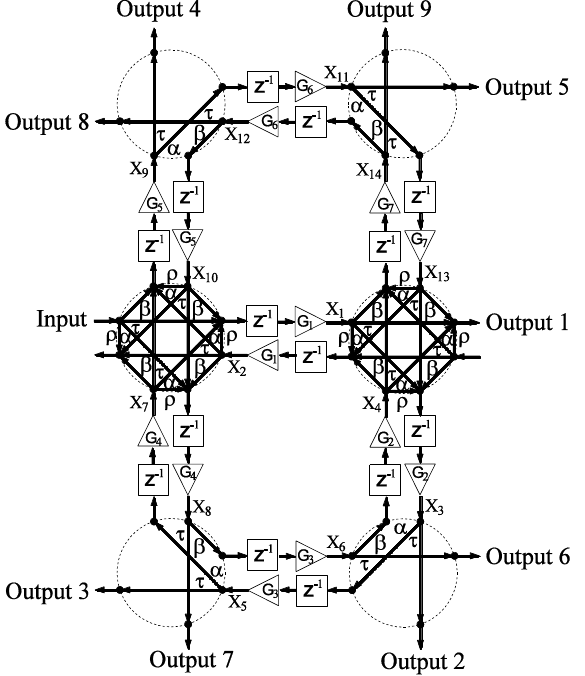
Figure 2. Network diagram of structure II. Transmitted,  , reflected,  , right-directed,  , and left-directed,  , coupler coefficient components. Photonic channelizer enabled by 4 two-port couplers and 2 four-port couplers, ....)3,2,1(  iG represent gain (triangles), 1  Z i represent unit delay (blocks), and X are internal states. Arrows indicate signal flow. i